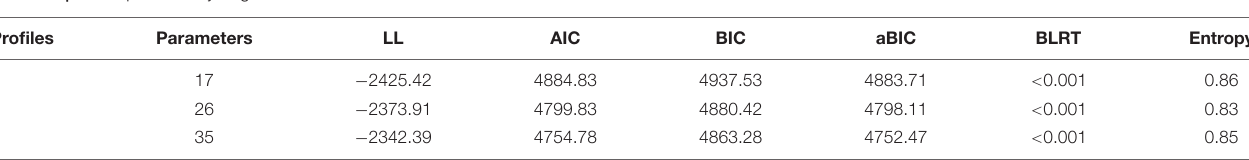
TABLE 4 | Latent profile analysis goodness-of-fit